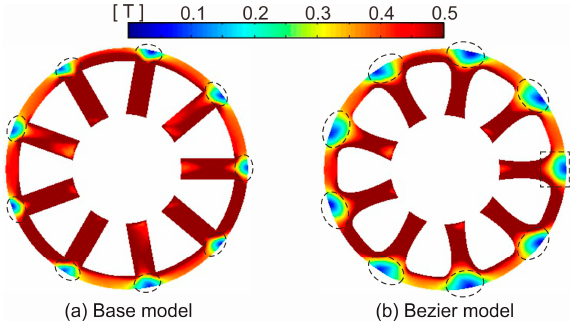
Figure 9. Magnetic flux density distribution of ( a ) the base model and ( b ) Bezier model shown by the low magnetic flux density range.